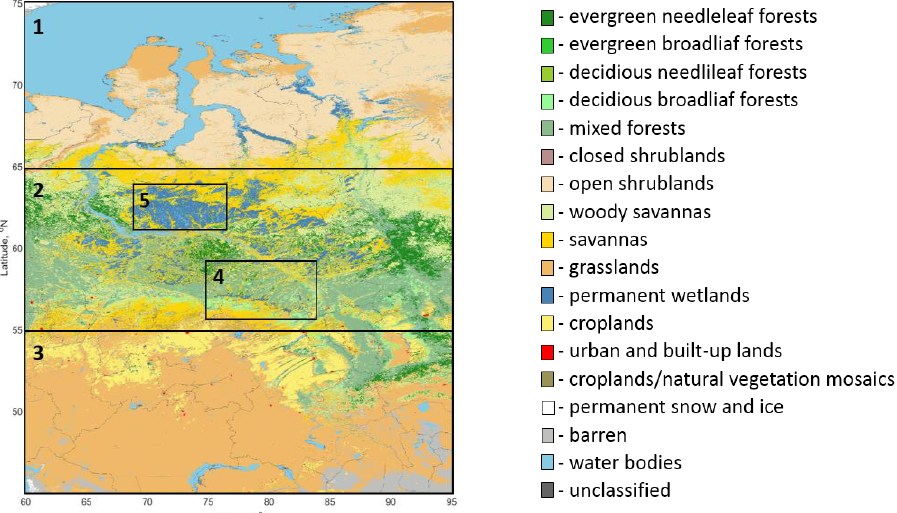
Figure 2. Vegetation and selected natural zones for Western Siberia on July 15, 2016: 1—Northern part; 2—Central part; 3—Southern part; 4—The Great Vasyugan Mire; 5—Permanent wetlands.